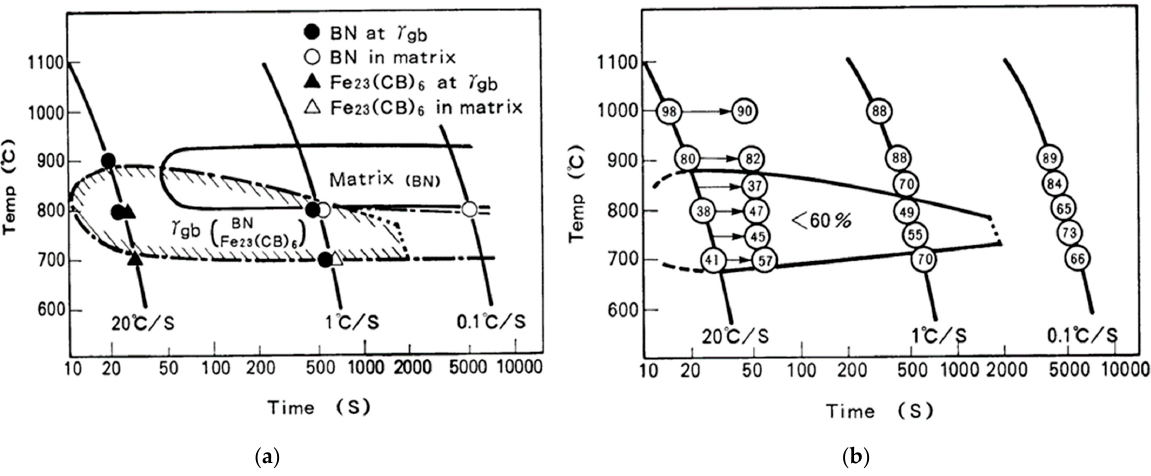
Figure 11. ( a ) PTT (precipitation–temperature–time) diagram for BN precipitation, both in the matrix and at grain boundaries. ( b ) Temperature–time–ductility diagram for boron-treated steels, with the cooling rate curves for 3 different cooling rates, 20 °C/s, 1 °C/s, and 0.1 °C/s. The